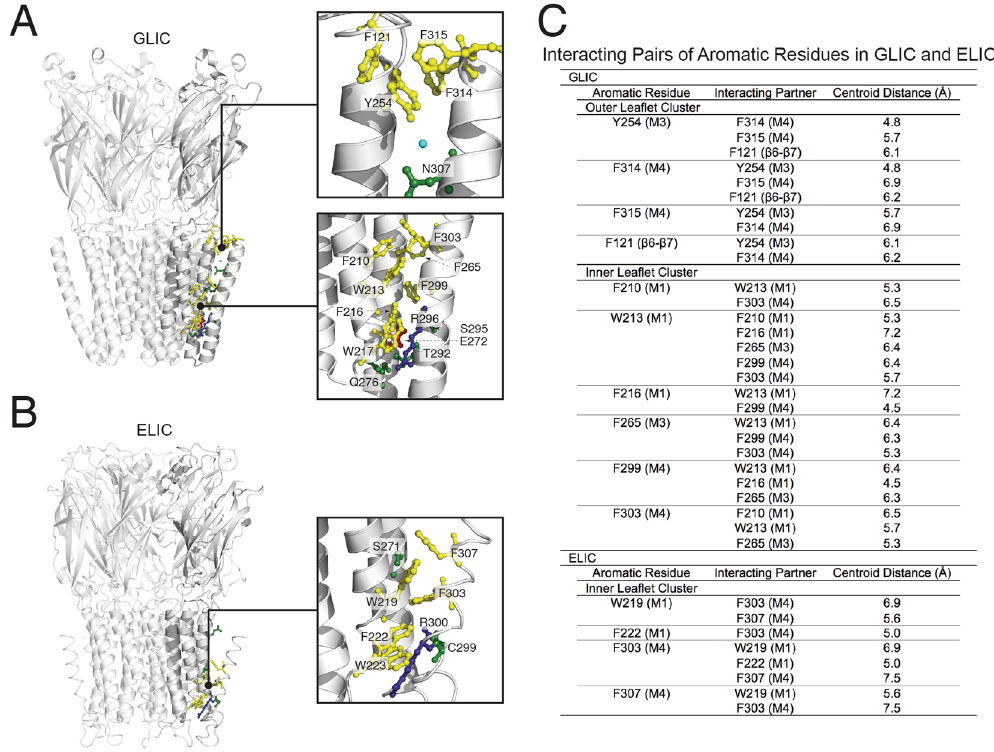
Figure 1. Side chain chemistry at the M4-M1/M3 interfaces of GLIC and ELIC. Structures of ( A ) GLIC (PDB: 4HFI) and ( B ) ELIC (B, PDB: 2VL0) showing on the left the full structure. The boxes on the right show the highlighted regions of GLIC and ELIC. Residues are coloured depending on their properties, aromatic (yellow), hydrogen bonding (green), negatively charged (red) and positively charged (blue). A water molecule in GLIC’s M4-M1/M3 interface is also shown (cyan). Note that aliphatic residues are not shown for clarity. ( C ) The centroid distances between interacting pairs of aromatic residues at the M4-M1/M3 interfaces of GLIC and